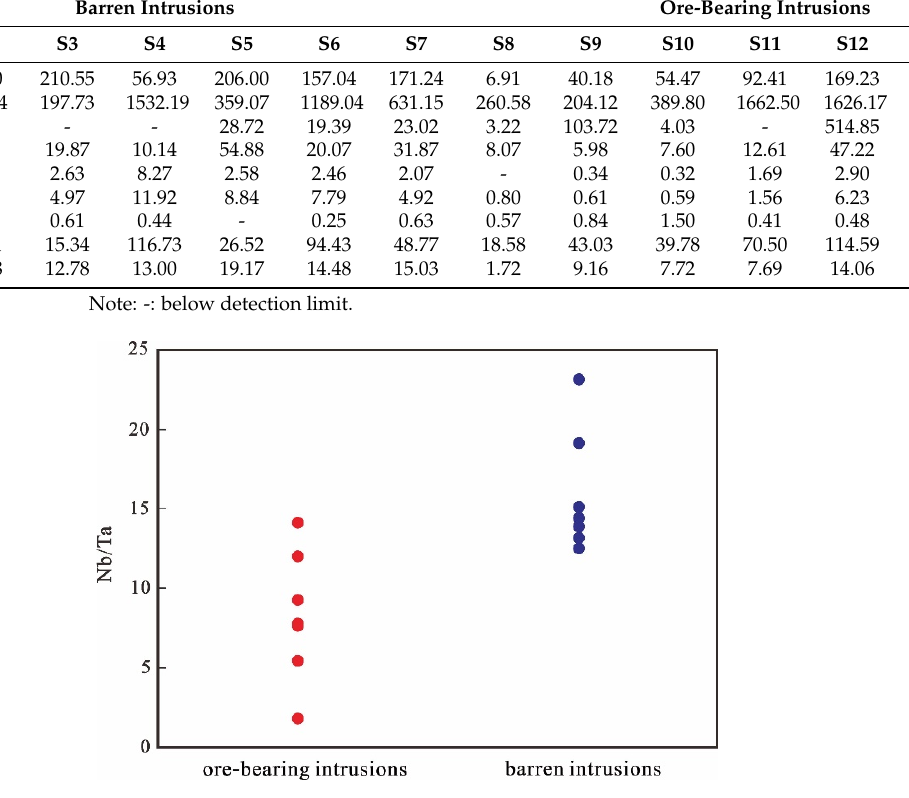
Figure 5. Nb/Ta input point diagram for ore-bearing intrusions and barren intrusions. Table 2. Results of the LA-ICP-MS of white micas (ppm).